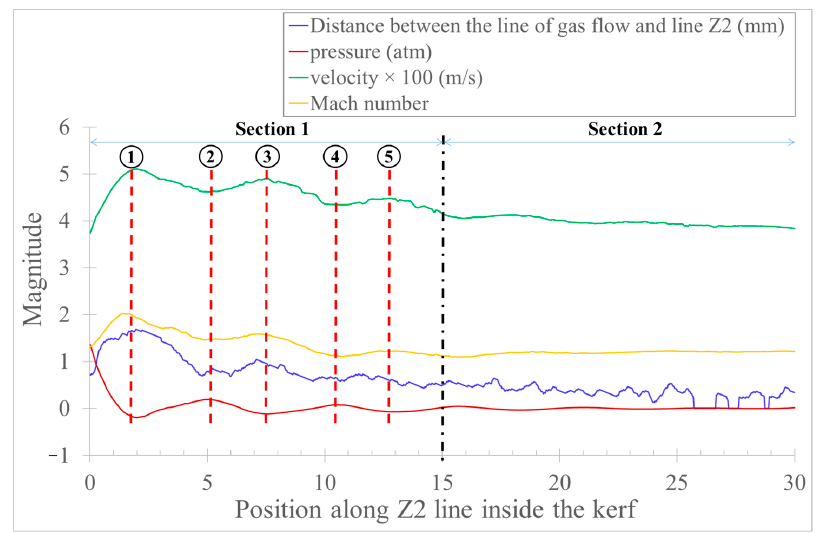
Figure 18. Comparison graph between simulation result and experiment (distance between the line of gas flow and line Z2; velocity; Mach number; and pressure).